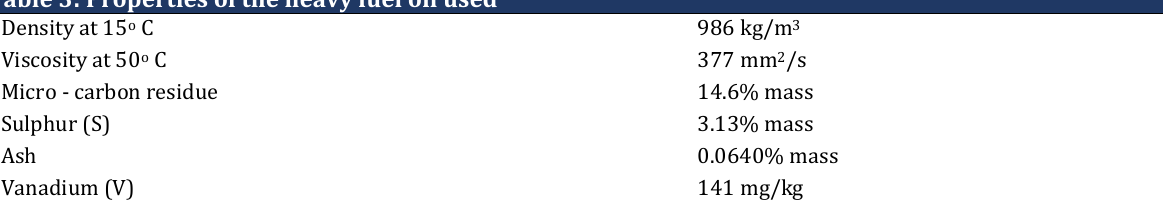
Table 3: Properties of the heavy fuel oil